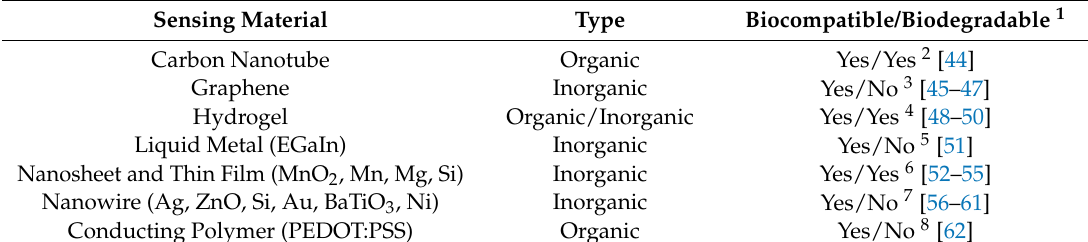
Table 1. Representative sensing materials for wearable and implantable FHE (flexible hybrid